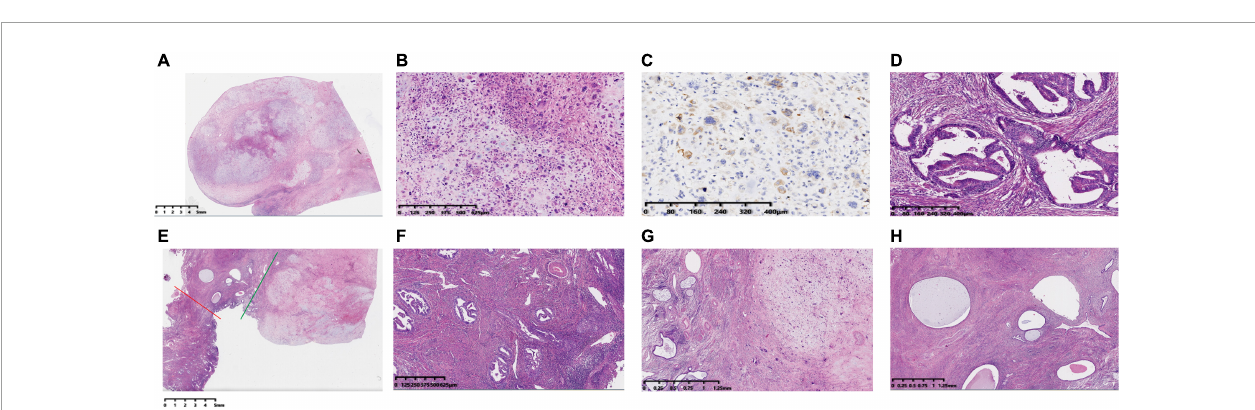
FIGURE2 Histopathology of the hysterectomy specimen HE stained and immunohistochemical staining of EMA in cervical carcinosarcoma. (A) Panoramic view of the histological appearance of a cervical cancer sarcoma under low magnification (HE). (B) The components of carcinoma and sarcoma are closely related and are mixed together under high-magnification microscopy. The morphology of cervical cancer is mainly sarcomatous with chondrogenic differentiation. (C) Immunohistochemistry of a cervical mass showing that the tumor cell cytosol was EMA positive. (D) A uterine mass showing endometrial adenocarcinoma. (E) The red line to the left indicates the uterine mass and the green line to the right indicates the cervical mass, both of them meeting at the endocervix, with normal endocervical glands and interstitium visible at low magnification (between the red and green lines). (F) High-magnification of a cervical mass involving the cervical mesenchyme with surface glandular phosphorylation—magnification. (G) Low-magnification microscopy of a cervical mass involving the endocervix—magnification. (H) Low-magnification view of the intersection of endometrial adenocarcinoma and cervical carcinosarcoma in the body of the uterus. The collision of these two tumors shows a clear